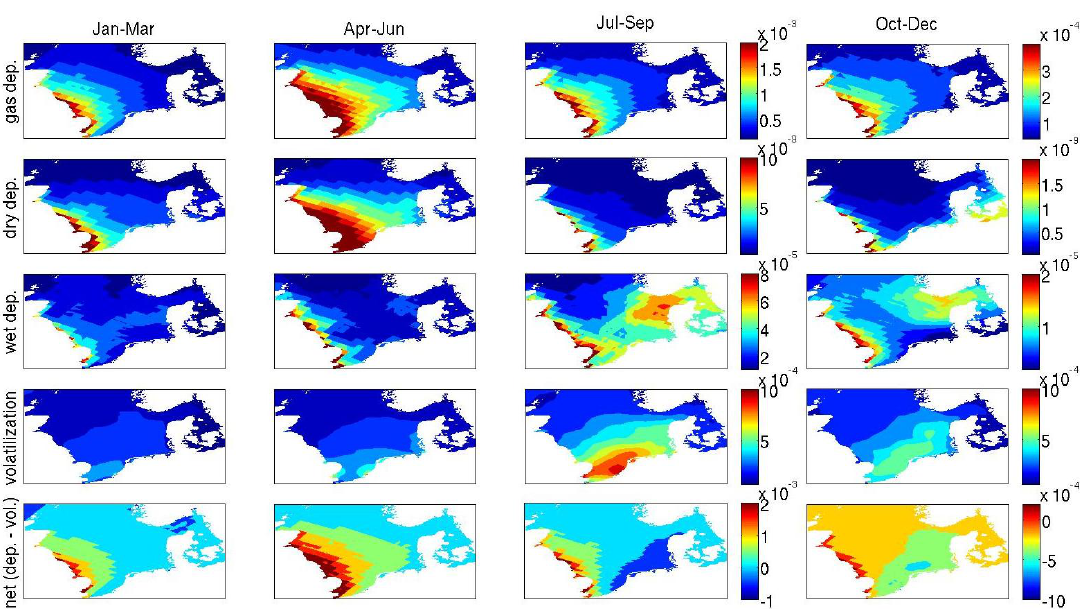
Figure 4. Distributions of quarterly (3 month) averaged rates of gas deposition ( top row ), dry deposition ( 2nd row ), wet deposition ( 3rd row ), volatilization ( 4th row ), and net air-sea exchange ( bottom row ) for γ-HCH in 2004. Rates are in (ng∙m −2 ∙s −1 ). Note: colorbar scales shown on 3rd column panels are used in connection with the left 3 panels. Note the change in scales for autumn (right figures), which are reduced relative to winter, spring and summer. Scales vary from row to